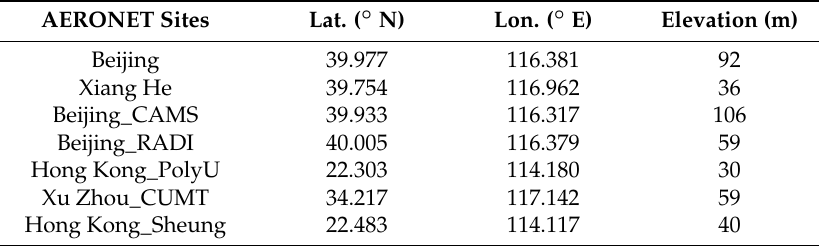
Table 1. AERONET site locations for the observation period